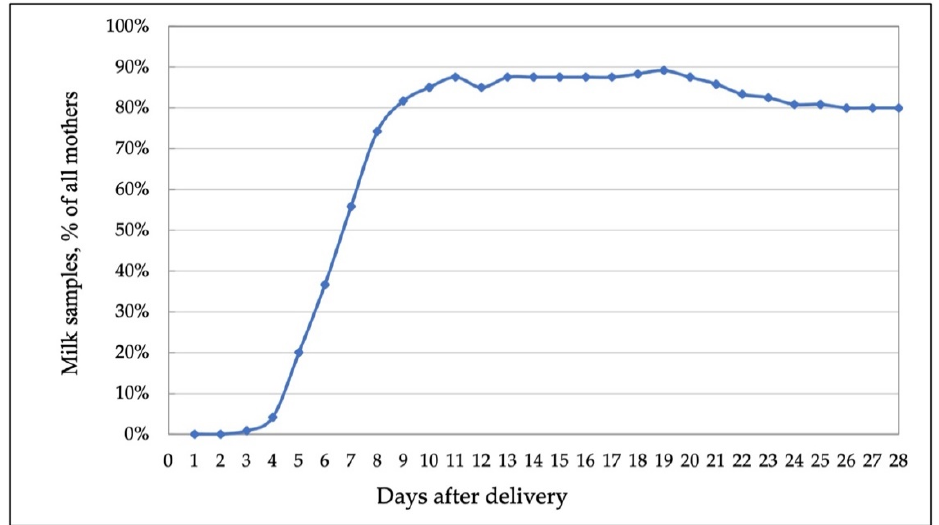
Figure 2. Amount of mother milk samples (% of all mothers) collected each day post-partum.